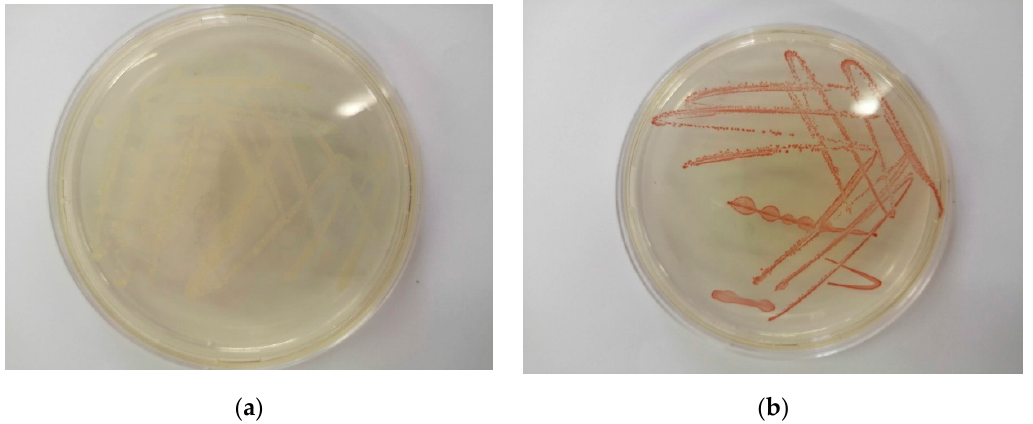
Figure 2. The growth of Enterococcus spp. colonies in ( a ) the absence and ( b ) the presence of 100 mM SeO 32 − after 24 h.